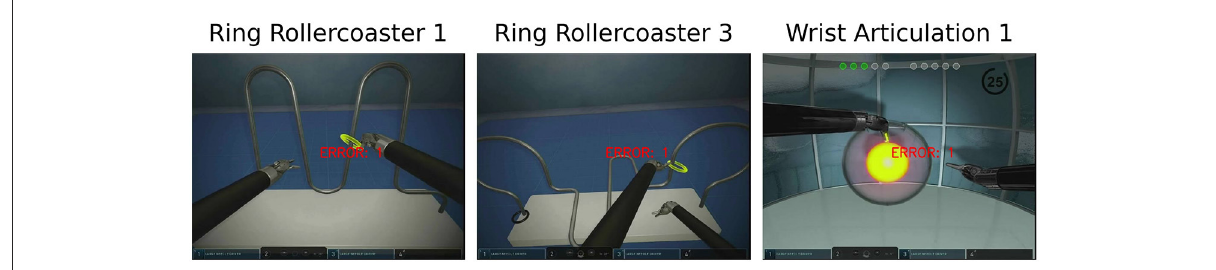
FIGURE3 Error detection example for simulation tasks.